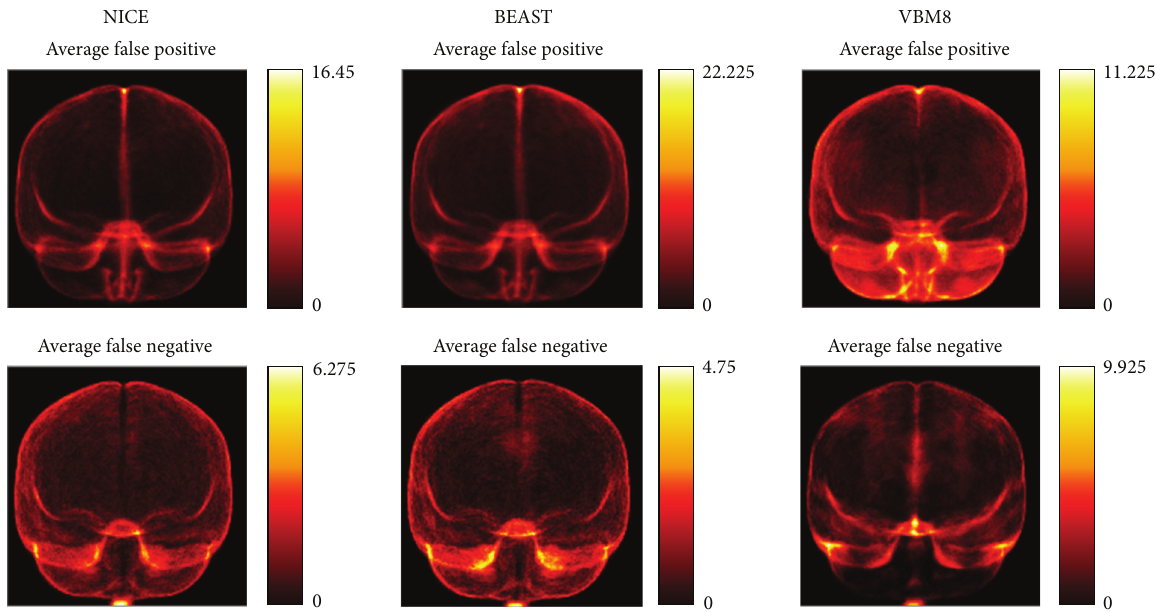
Figure 7: False positive and false negative maps for NICE, BEaST, and VBM8 on SVE dataset. VBM8 tended to produce a systematic oversegmentation compared to the used manual gold standard. The errors obtained by NICE and BEaST were more uniformly distributed indicating nonsystematic segmentation errors. Note that in the images provided by the SVE website the vertical scale measuring error is not the same over all images.